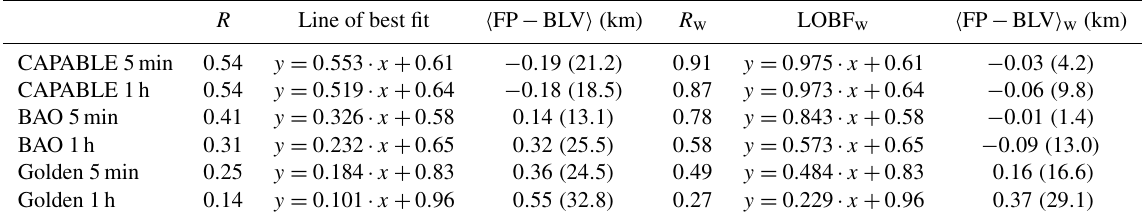
Table 4. Summary of statistics for the BLView-collected/STRAT-processed and the BLView-collected/BLView-processed MLH estimates. Values in parentheses indicate percent of the difference value with respect to the BLView-derived MLH, and the w subscript indicates a weighting function was applied. Data were resampled to 5min resolution followed by application of filtering criteria to both data sets (lines labeled 1h present statistics after data were filtered and subsequently resampled by a 1h block average). Herein, the comparison is limited strictly to the MLH algorithms.